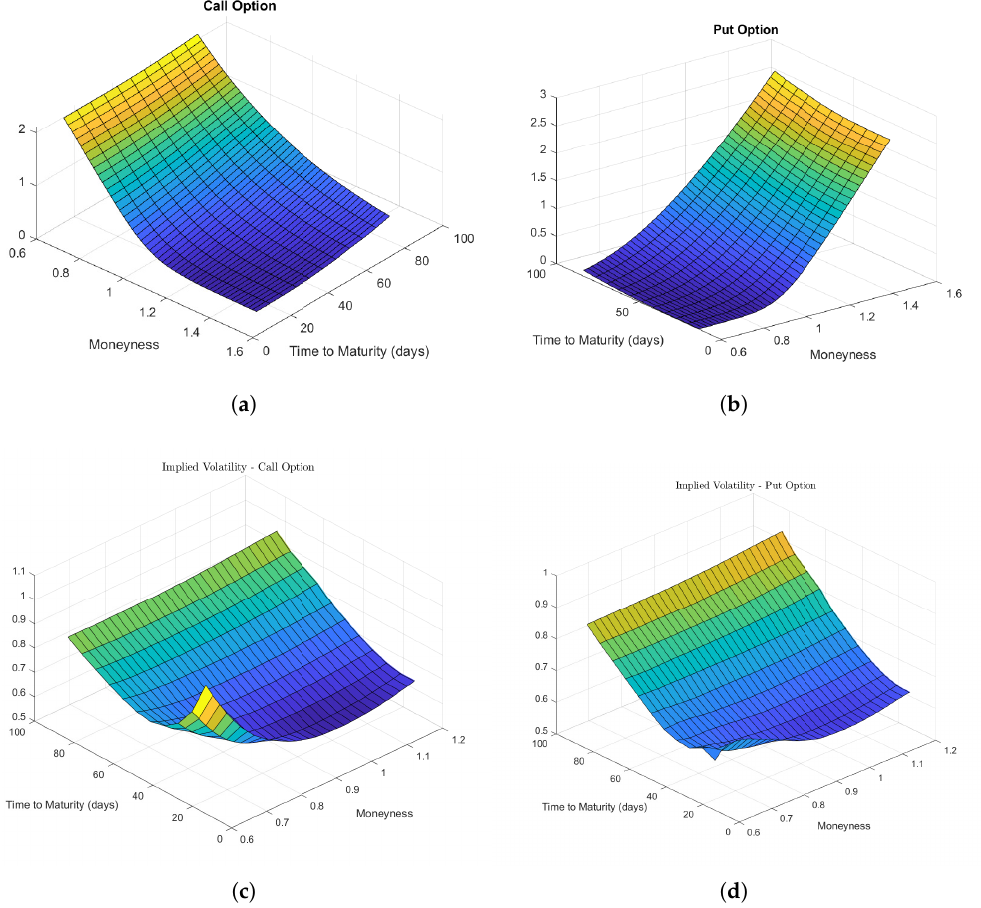
Figure 14. Call and put options prices for different maturities and moneyness, panels ( a , b ). Panels ( c , d ) show implied volatility